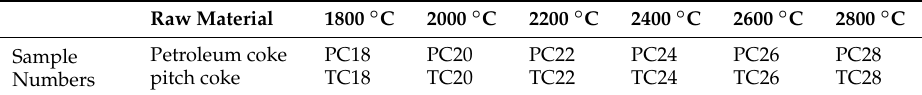
Table 1. The different temperatures list and the post-processing